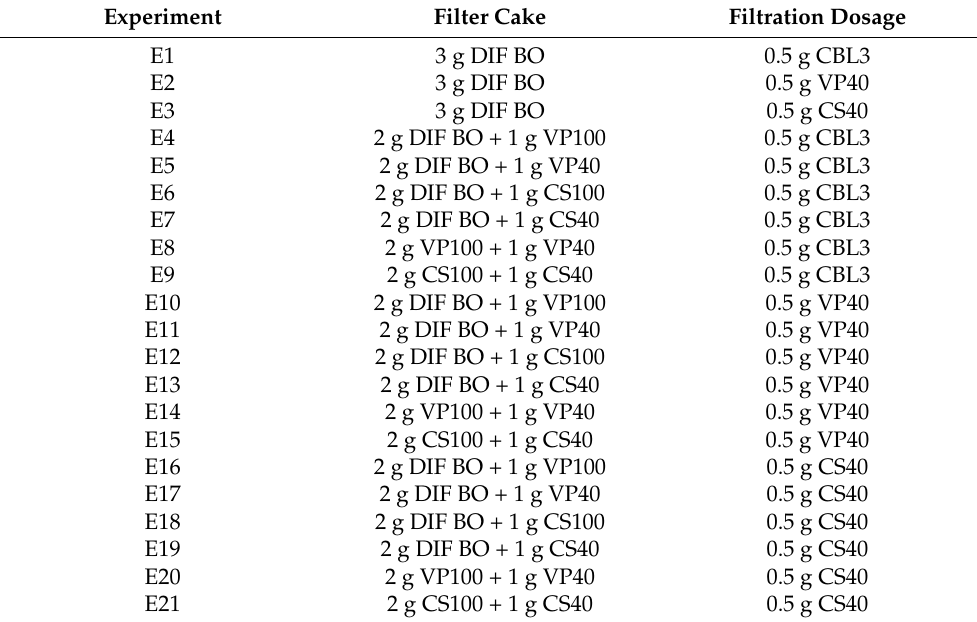
Table 1. Filter aids and quantities used as filter cake and filtration dosage for clarification of 100 mL beer in the filtration